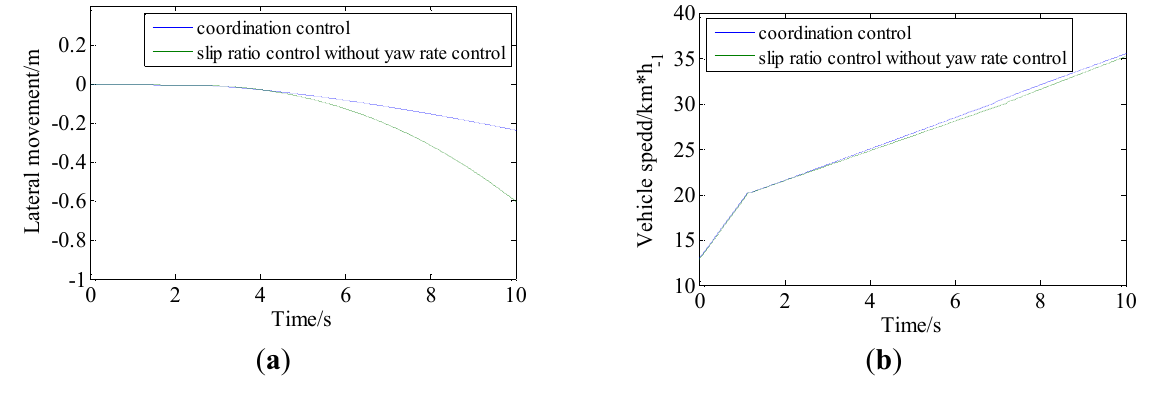
Figure 12. Simulation results of acceleration slip regulation on variation split- μ road: ( a ) slip ratios of driving wheels; ( b ) yaw rate of vehicle; ( c ) torque commands of slip ratio control and yaw rate control; and ( d ) motor torque outputs.